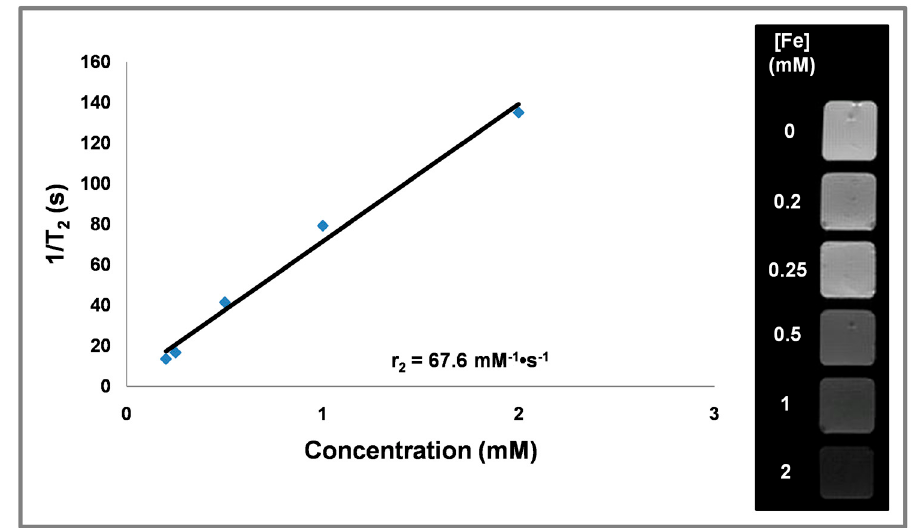
Figure 6. Plot of transverse relaxation rate (1 / T 2 ) over the Fe concentration of PEGylated CF@MF NPs, measured at 9.4 T (left). Transverse relaxivity ( r 2 ) corresponds to the slope of the regression (black line). Representative T 2 -weighted MRI image of a phantom containing solutions of PEGylated CF@MF NPs at different concentrations (right).